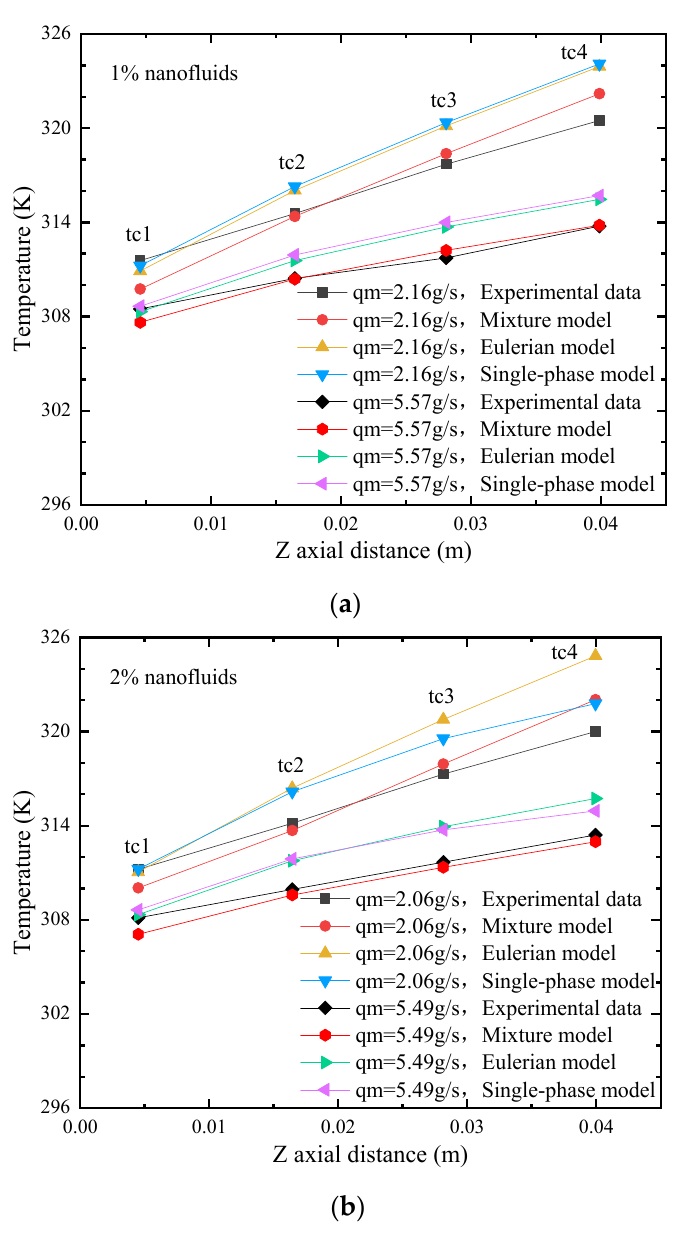
Figure 3. Simulated and experimentally measured wall temperature along the flow direction with different mass flow rates. ( a ) 1% volume fraction. ( b ) 2% volume fraction. Figure 4 shows the pressure drop predicted by the mixture model for the volume fraction of 2%. Comparing the experimental and numerical results, it can be found that the maximum error is only 2.03%. Therefore, the flow characteristics simulated based on mixture model also agree very well with the